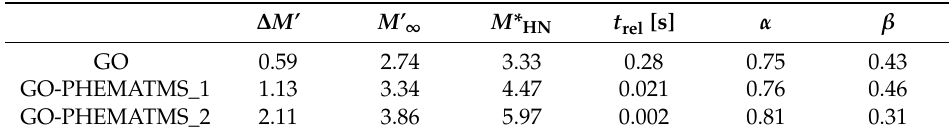
Table 3. Parameters of the Havriliak–Negami model, obtained after fitting related to the ER efficiency of the 5 wt.% ER fluids consisting of the various particles under investigation.